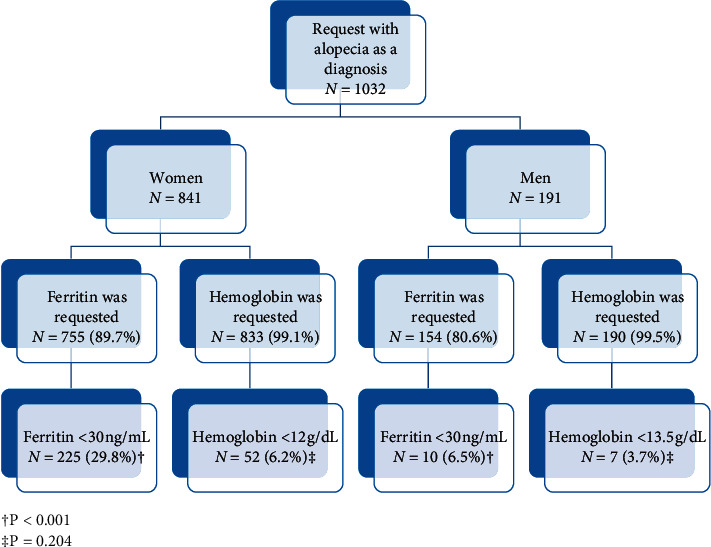
Results of the prospective study legend: †P < 0.001 and ‡P=0.204.